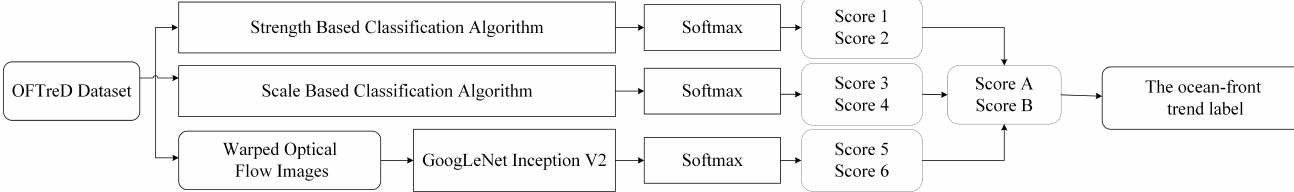
Figure 2. The overall network architecture. The input video sequences are fed to three parallel networks. The input frames of the Ocean-Front Trend Database (OFTreD) are fed to the strength and scale-based classification algorithms directly without pre-processing. However, the input frames of the OFTreD dataset are pre-processed to form warped optical flow images, before feeding to a GoogLeNet Inception network. Besides, for the three parallel networks, Scores 1 to 6 are produced. Scores 1, 3, and 5 are combined to obtain the Score A, and scores 2, 4, and 6 are combined to obtain the Score B according to Equations (1) and (2). These two scores are used to determine if the oceanfront is under enhancement or attenuation, Score A is for enhancement and Score B for